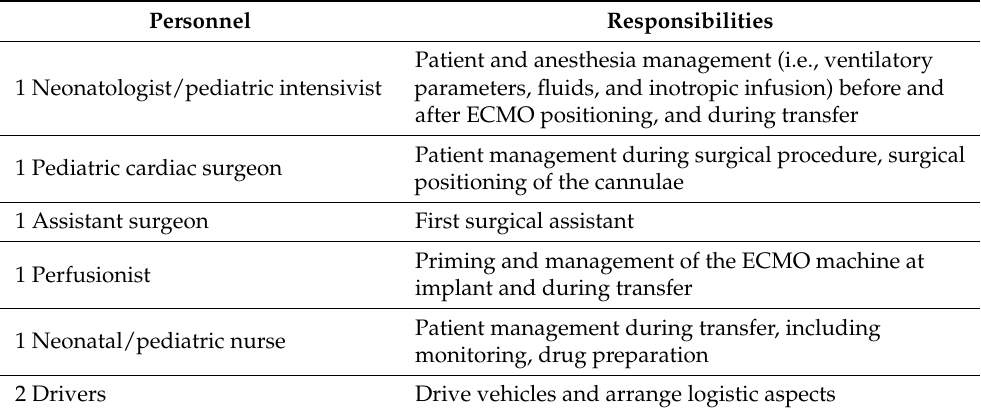
Table 1. Personnel and roles of the ECMO